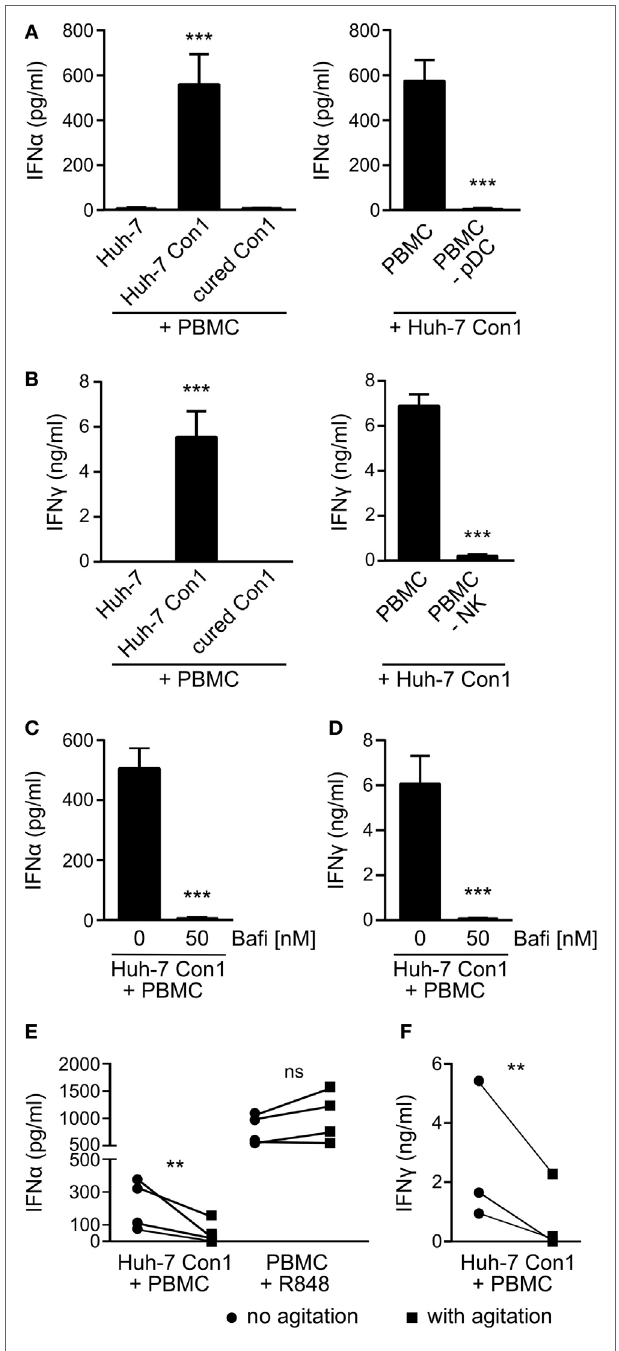
FigUre 1 | Plasmacytoid dendritic cells (pDCs) and natural killer (NK) cells are activated by hepatitis C virus subgenomic replicon cells. Huh-7 cells were co-cultured with peripheral blood mononuclear cells (PBMCs) overnight and cytokines measured by ELISA. (a) IFN α levels in co-cultures with PBMCs or with PBMCs depleted from pDCs (PBMC -pDC) ( n = 3). (B) IFN γ levels in co-cultures with PBMCs or with PBMC depleted from NK cells (PBMC -NK) ( n = 3). (c,D) IFN α and IFN γ secretion in PBMCs that were treated with Bafilomycin (Bafi) for 1 h before setting up co-cultures ( n = 3). (e,F) IFN α and IFN γ levels in co-cultures that underwent continuous mechanical agitation (orbital shaker, 200 rpm) compared to co-cultures without agitation. PBMCs stimulated with R848 (1 µg/ml) were used as